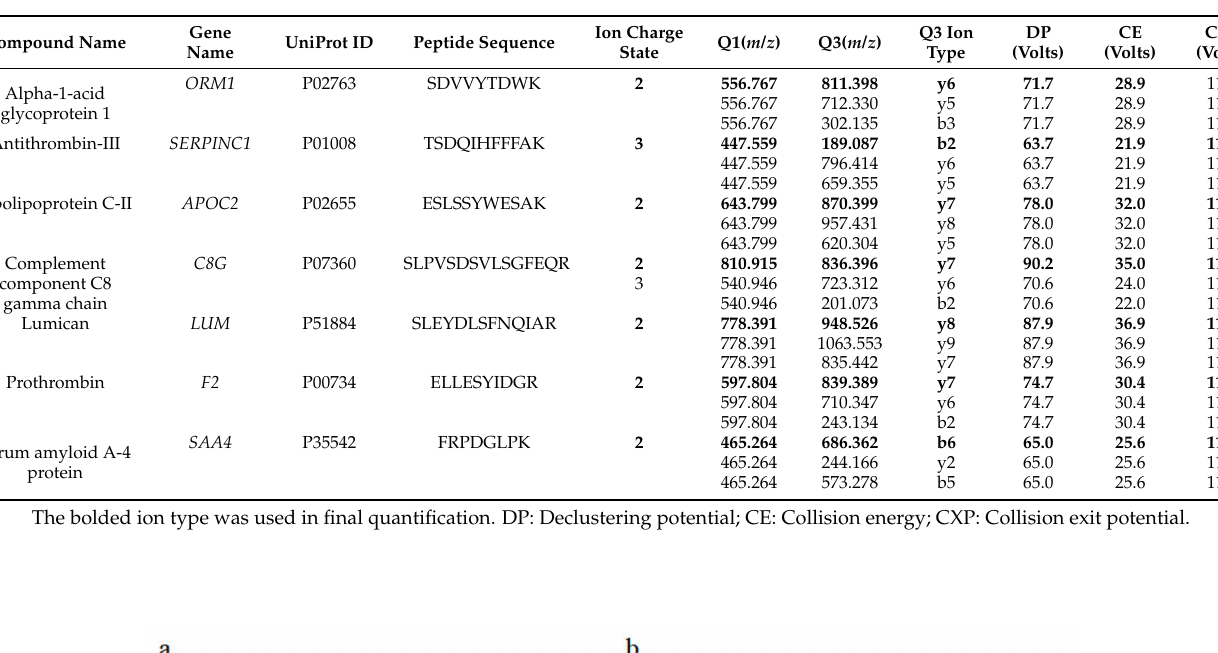
Table 3. Peptide parameters for MRM.